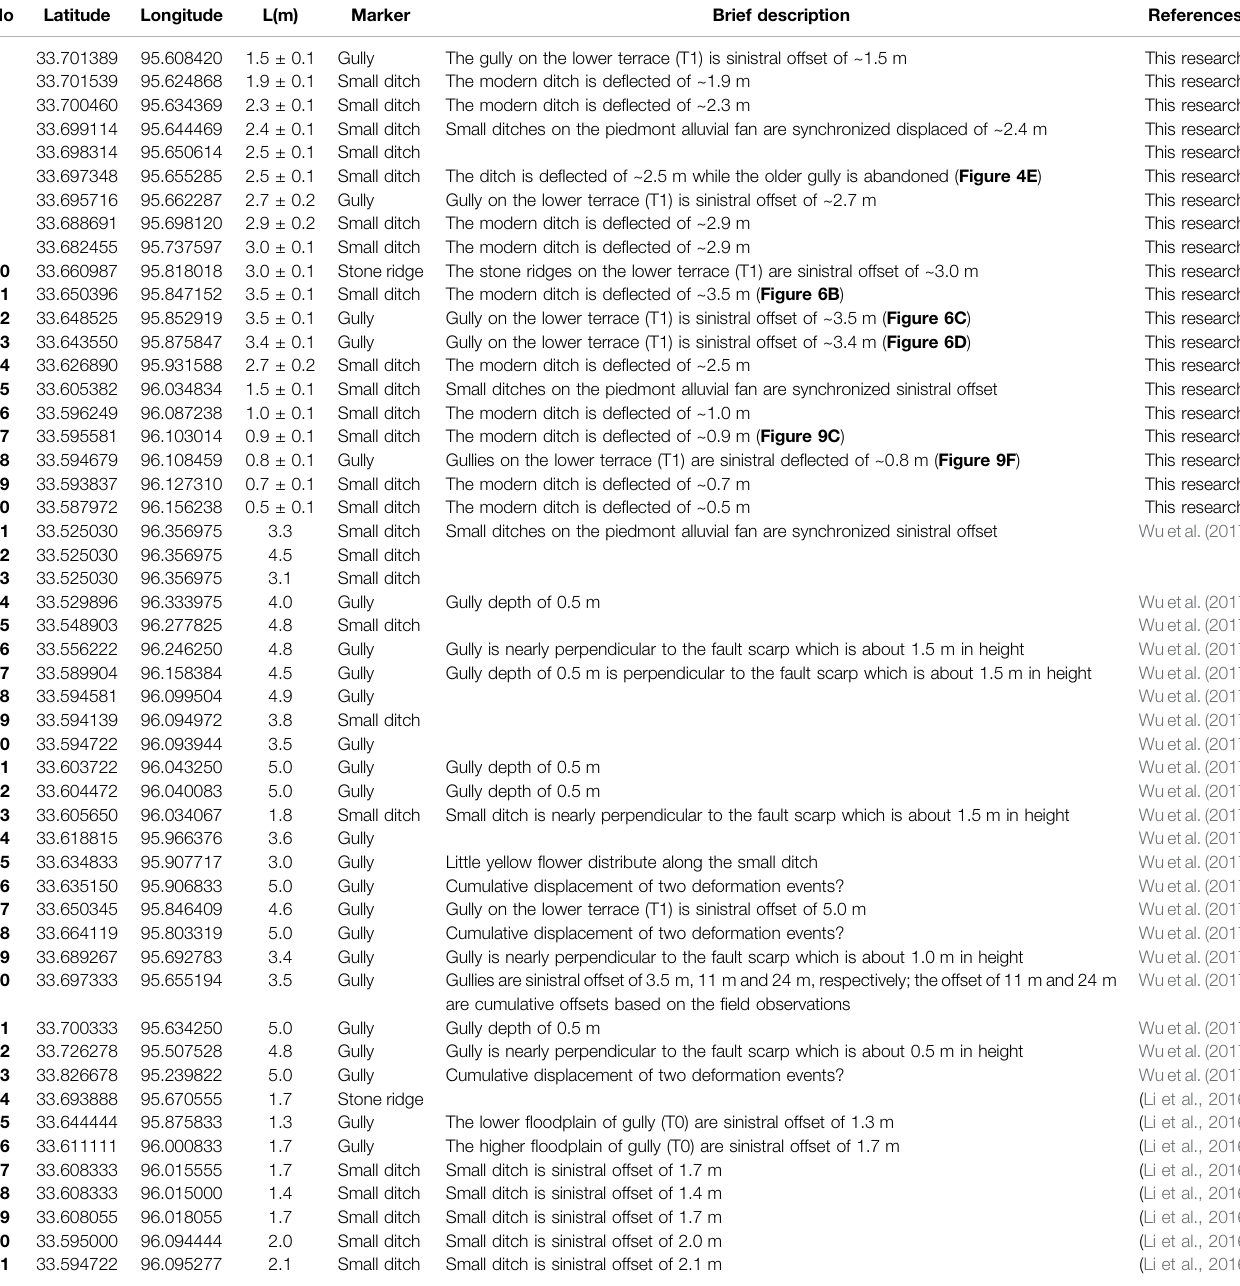
TABLE 2 | Distribution of co-seismic displacements in CE 1738 Dangjiang